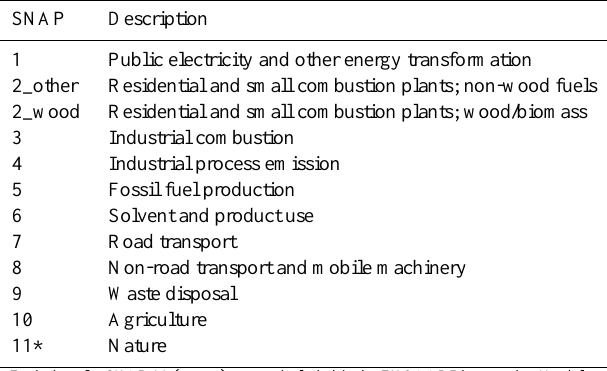
Table 1. Description of source categories in the